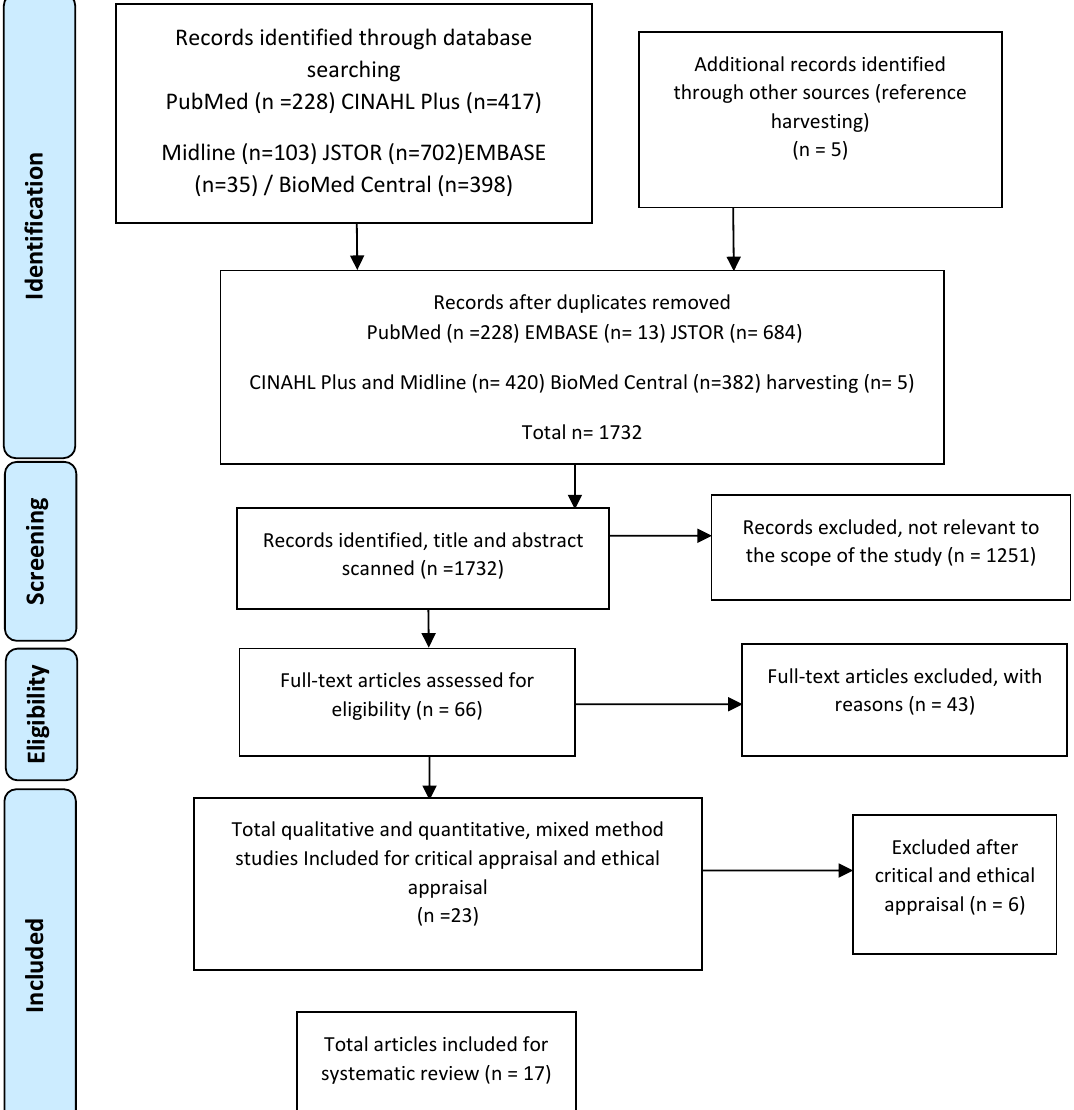
Figure 1. Preferred Reporting Items for Systematic Reviews and Meta-Analyses (PRISMA) 2009 flow diagram.